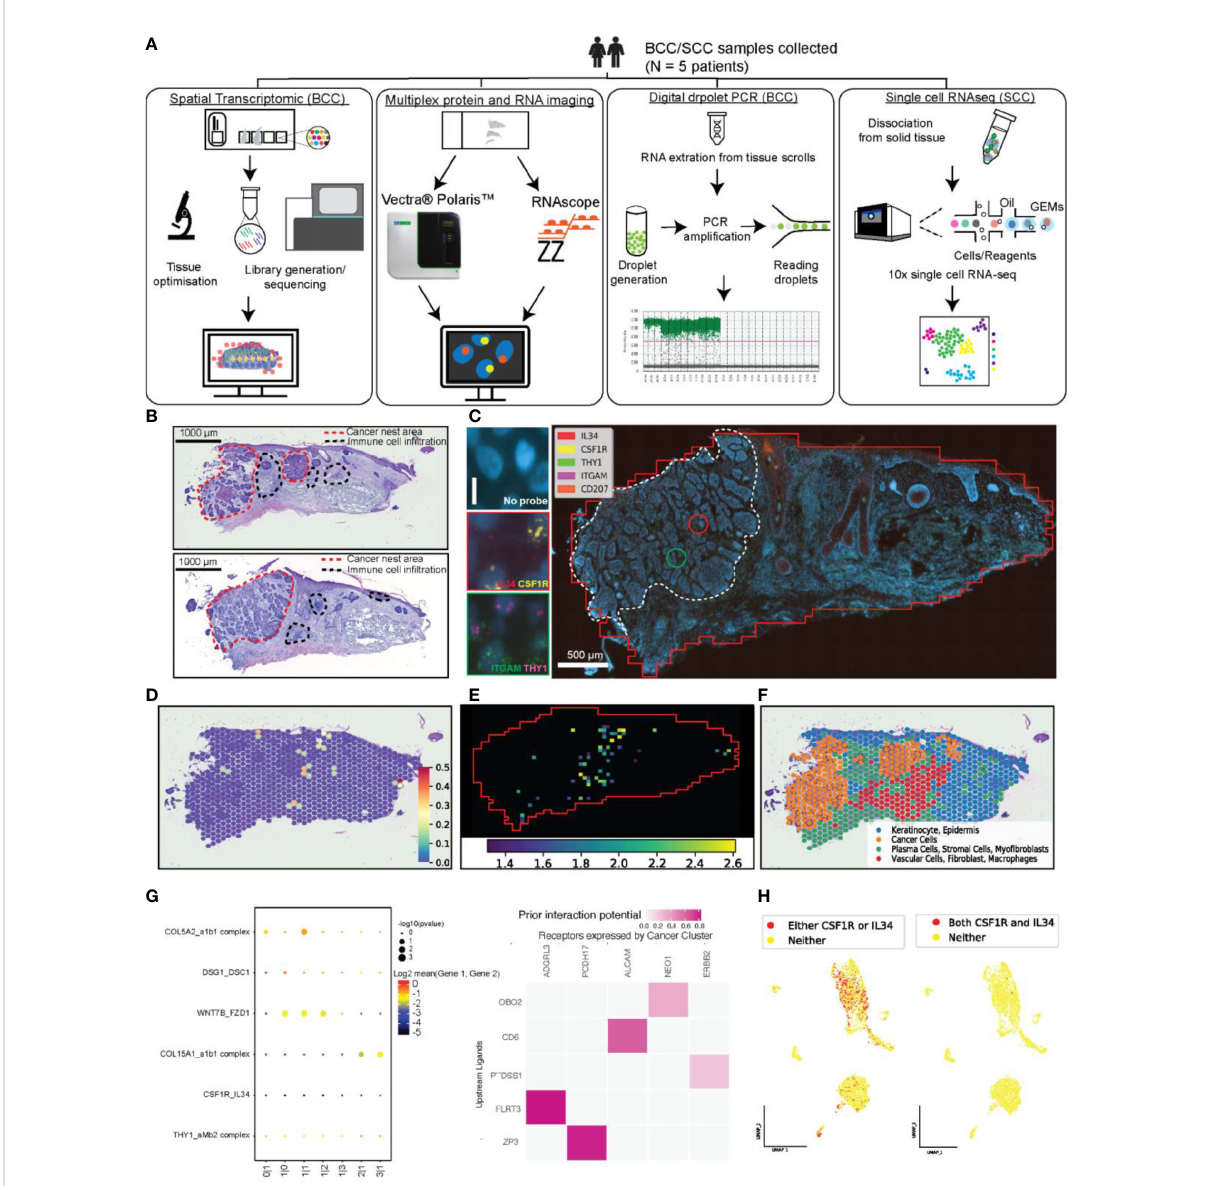
FIGURE 1 An integrated technological and computational approach to study cell-cell interaction across the whole tissue section. (A) A work fl ow illustrating the combination of four technologies to study L-R interaction in skin cancer tissue, including Visium Spatial Transcriptomic (ST-seq), RNAscope Hiplex, Opal multiplex protein imaging, scRNA-seq, and optionally digital droplet PCR (ddPCR). (B) The annotated H&E images of the two adjacent tissue sections that were used for Visium ST analysis (top) and the consecutive section of the same block used in RNAscope assay (bottom). (C) Target RNA molecule expression at a single cell level using RNAscope assay and the visualization of the local co-expression of two pairs L-R including IL34-CSF1R and THY1-ITGAM (left panel). (D) Using ST-seq data and ligand-receptor expression analysis of neighbouring spots to determine signi fi cant local co- expression level of IL34-CSF1R (the color bar shows the ligand-receptor score). (E) Results from our STRISH computational pipeline reported in this paper to analyse RNAscope imaging data, showing the detection of the local co-expression of IL34-CSF1R. The heatmap shows the windows with signi fi cant level of co-expression of ligand-receptor pair (scored by -log10 of p-values). The red solid line box indicates an example of a tissue region where consistent cell-cell interactions occur in ST-seq and RNAscope analysis. (F) Spatial feature plots of the four distinct clusters de fi ned by Louvain graph-based clustering. The annotation was based on differential gene and pathway analysis. The distribution of the cluster annotated as cancer was consistent with the location of cancer nests in the upper H&E image shown in (B) . (G) The inference of ligand-receptor based cellular communications from ST-seq data, using CellPhoneDB (left) (11) and NicheNet (right) (6). For CellPhoneDB prediction, top four highly active pairs of ligand-receptor and the two target pairs were selected for visualization together with IL34-CSF1R and THY1-ITGAM. (H) The UMAP feature plots highlighted the cells that expressed either CSF1R or IL34 (red dots, left plot) and both CSF1R and IL34 (Cyan dots, right